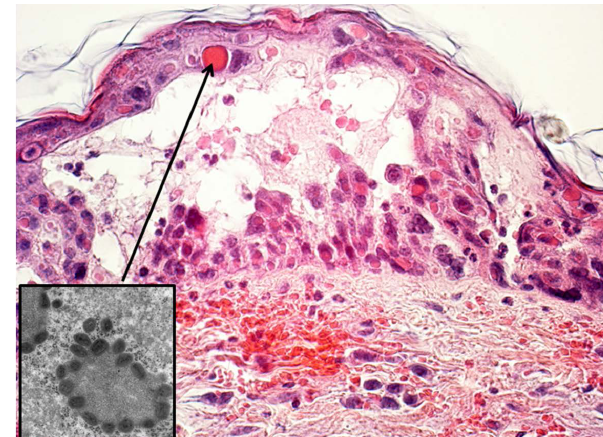
Figure 6. Skin lesions due to a calpox infection in a marmoset ( Cal- lithrix jacchus ). Apart from inflammatory signs calpox lesions are characterized by so-called Guarnieri bodies (arrow) within the cy- toplasm of epithelial cells. Transmission electron microscopy of the Guarnieri bodies presents orthopoxvirus particles (inset).